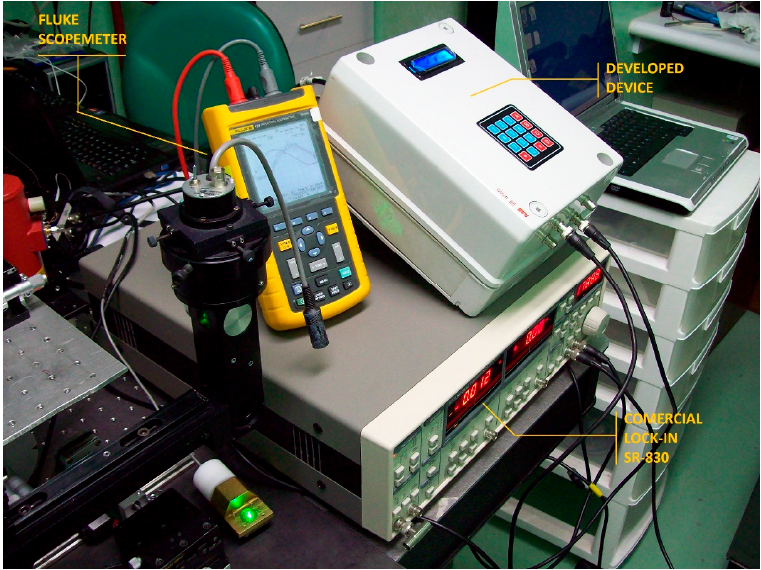
Figure 8. Developed core from the performed device can be implemented in the same FPGA circuit 10 times or more depending of the FPGA circuit used resulting in saving space, weight and cost implementation.